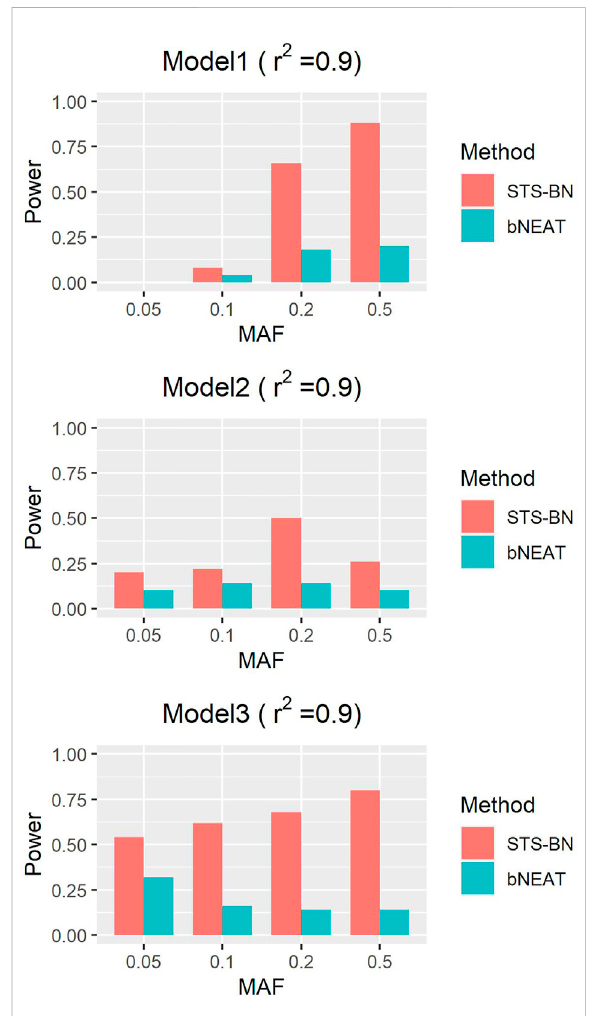
FIGURE 6 Performance comparison of STS-BN and bNEAT. The input orders of markers are randomly disturbed and r 2 =